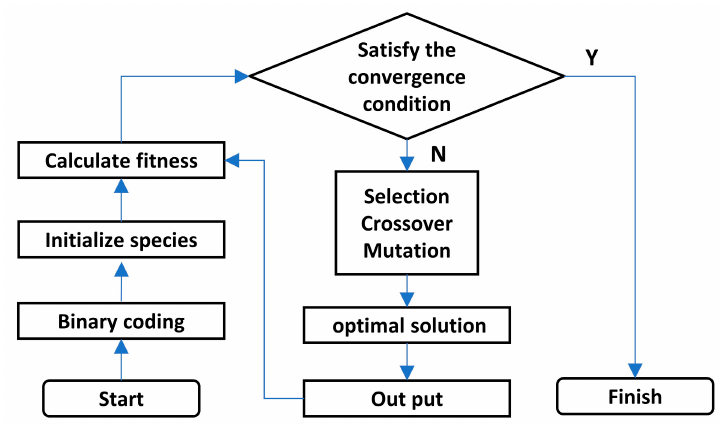
Figure 3. Genetic optimization algorithm workflow.